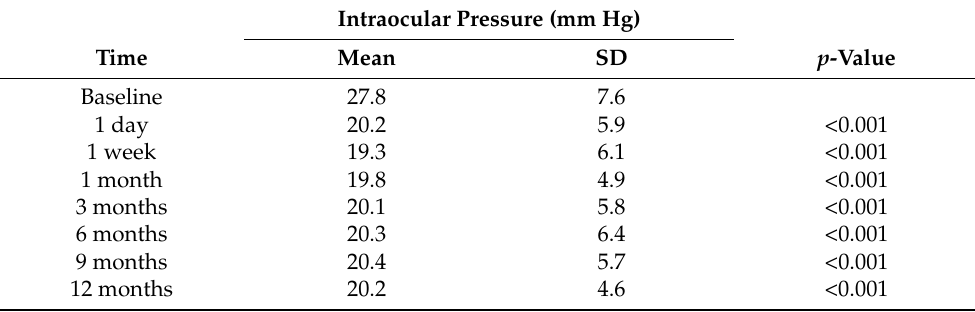
Table 2. Intraocular pressure at various postoperative time points compared to the